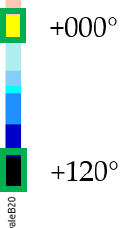
Figure 10. Illustration of stacked graphs of different illumination error rates for a single user.